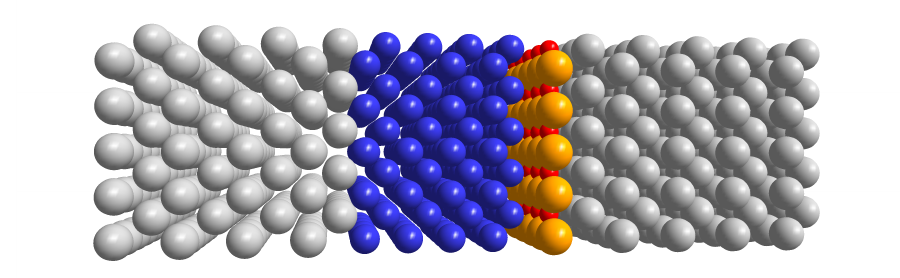
Figure 1. Schematic representation of the devices under investigation. Gold or platinum leads (grey) are intercalated with chromium (blue) and possibly an insulating layer of magnesium oxide (orange and red spheres,